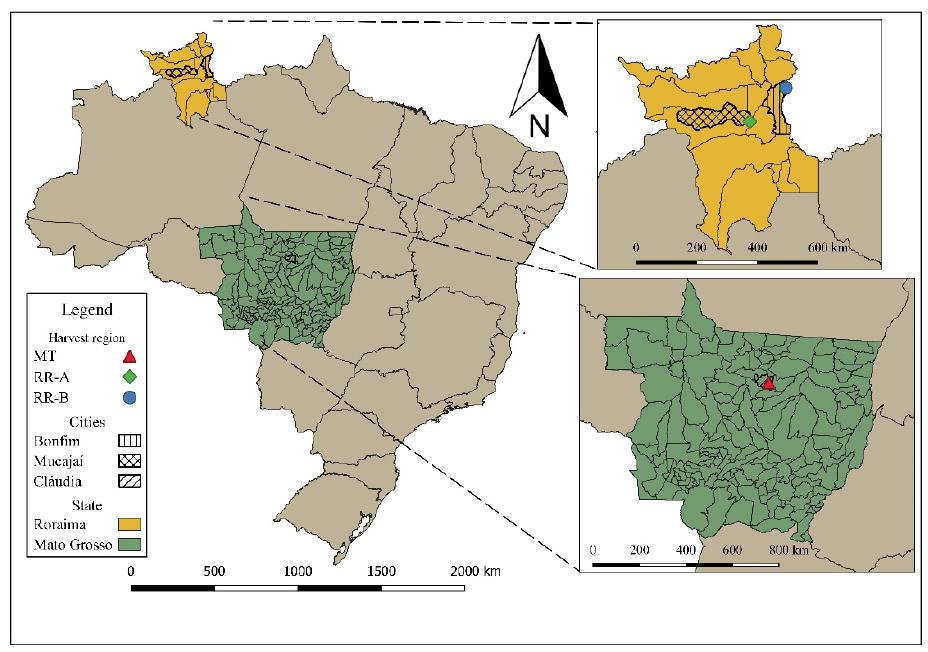
Figure 1. The geographical location of wood harvesting areas.